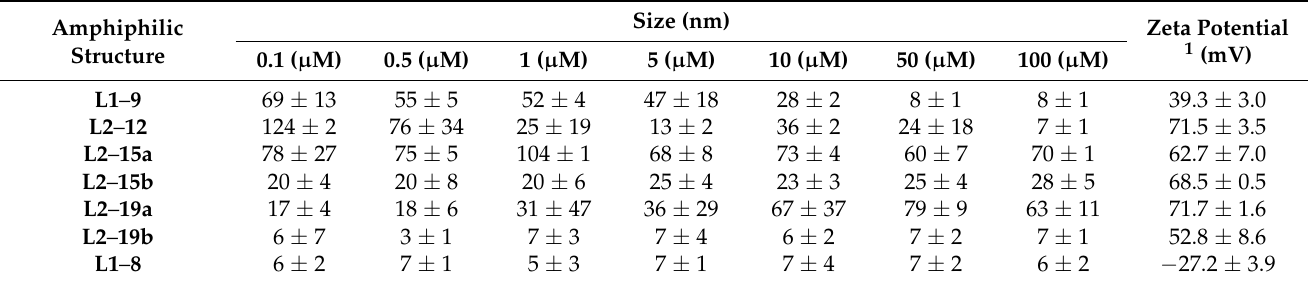
Table 1. Changes in hydrodynamic diameter of amphiphilic dendrons solution and Zeta potential